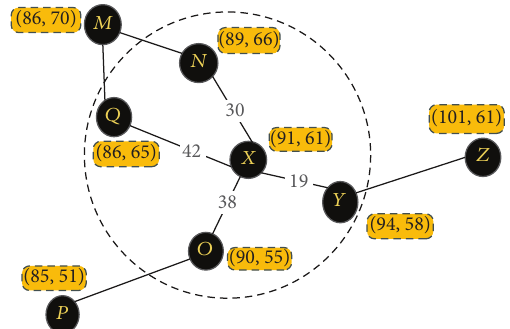
Figure 2: Resulting topology of node 𝑋 after link selection phase.